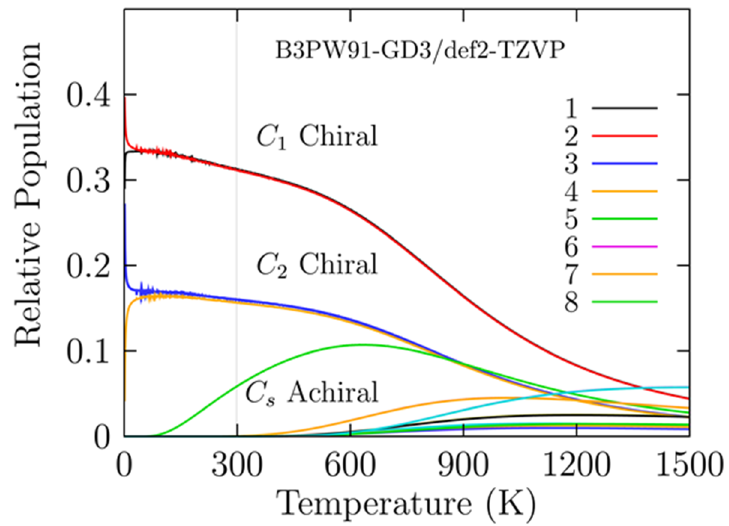
Figure 4. (Color online) Probability of occurrence for all isomers at temperatures ranging from 20 to 1500 K. The red and black solid lines depict the probability occurrence of the putative chiral global minimum with symmetry C 1 and strongly dominate in all ranges of temperatures. The bulk melting temperature of copper is 1358 K [105]; thus, our results below this temperature are consistent. Prob- ability of occurrence or thermal population computed with DFT functionals: TPSS, PBE, and BP86 are displayed in Figure S3.